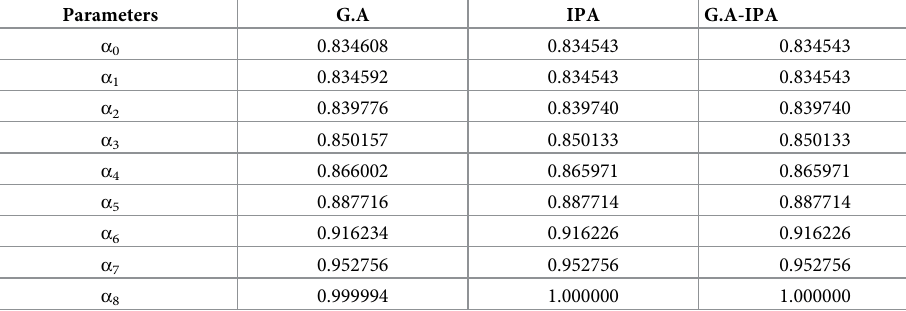
Table 12. Unknown parameters achieved by G.A, IPA and GA-IPA for δ = 0.6. Parameters